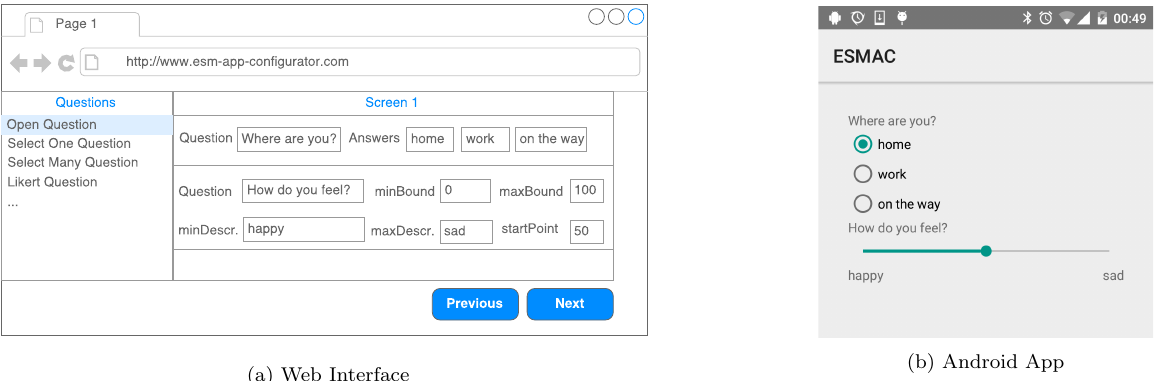
Figure 2: Visualization of a configuration within an exemplary web interface’s question frame and within the Android app.